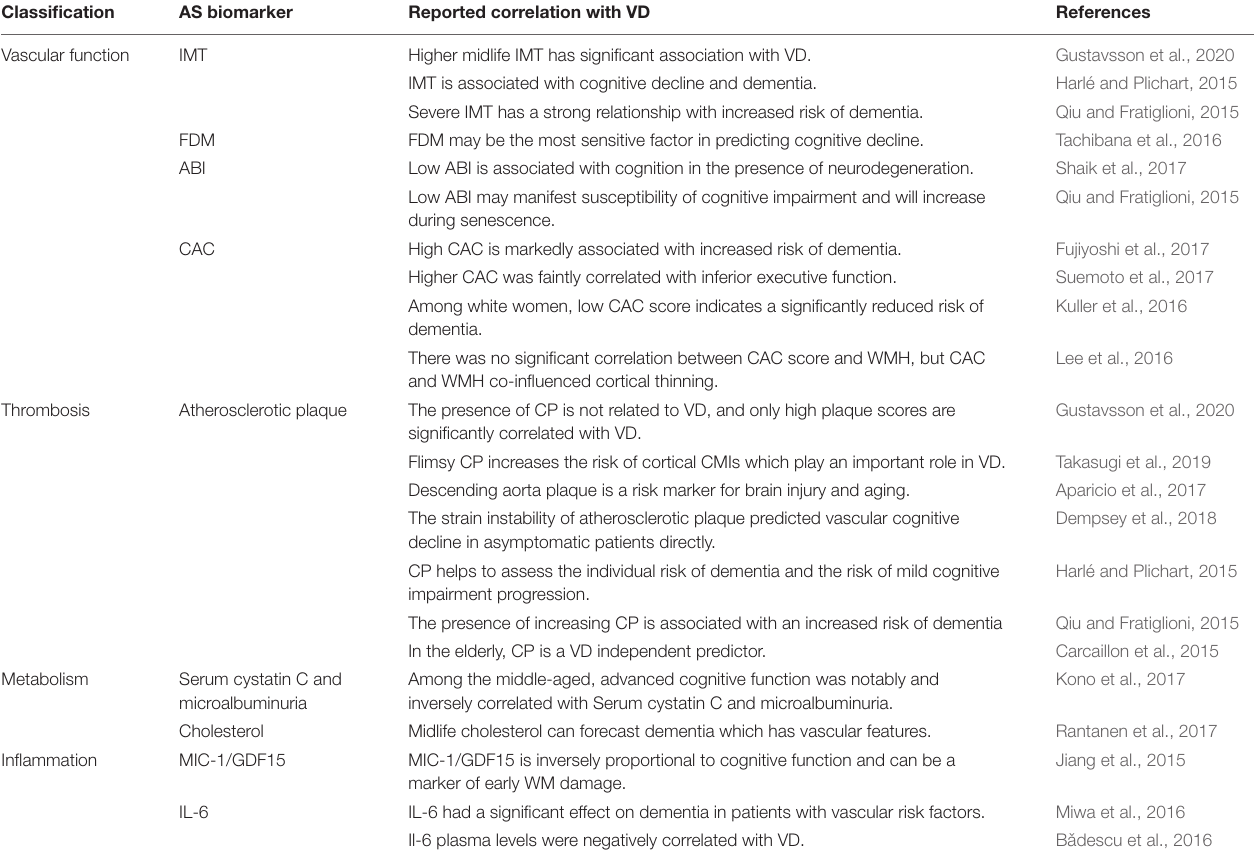
TABLE 1 | Summary of the AS biomarkers in